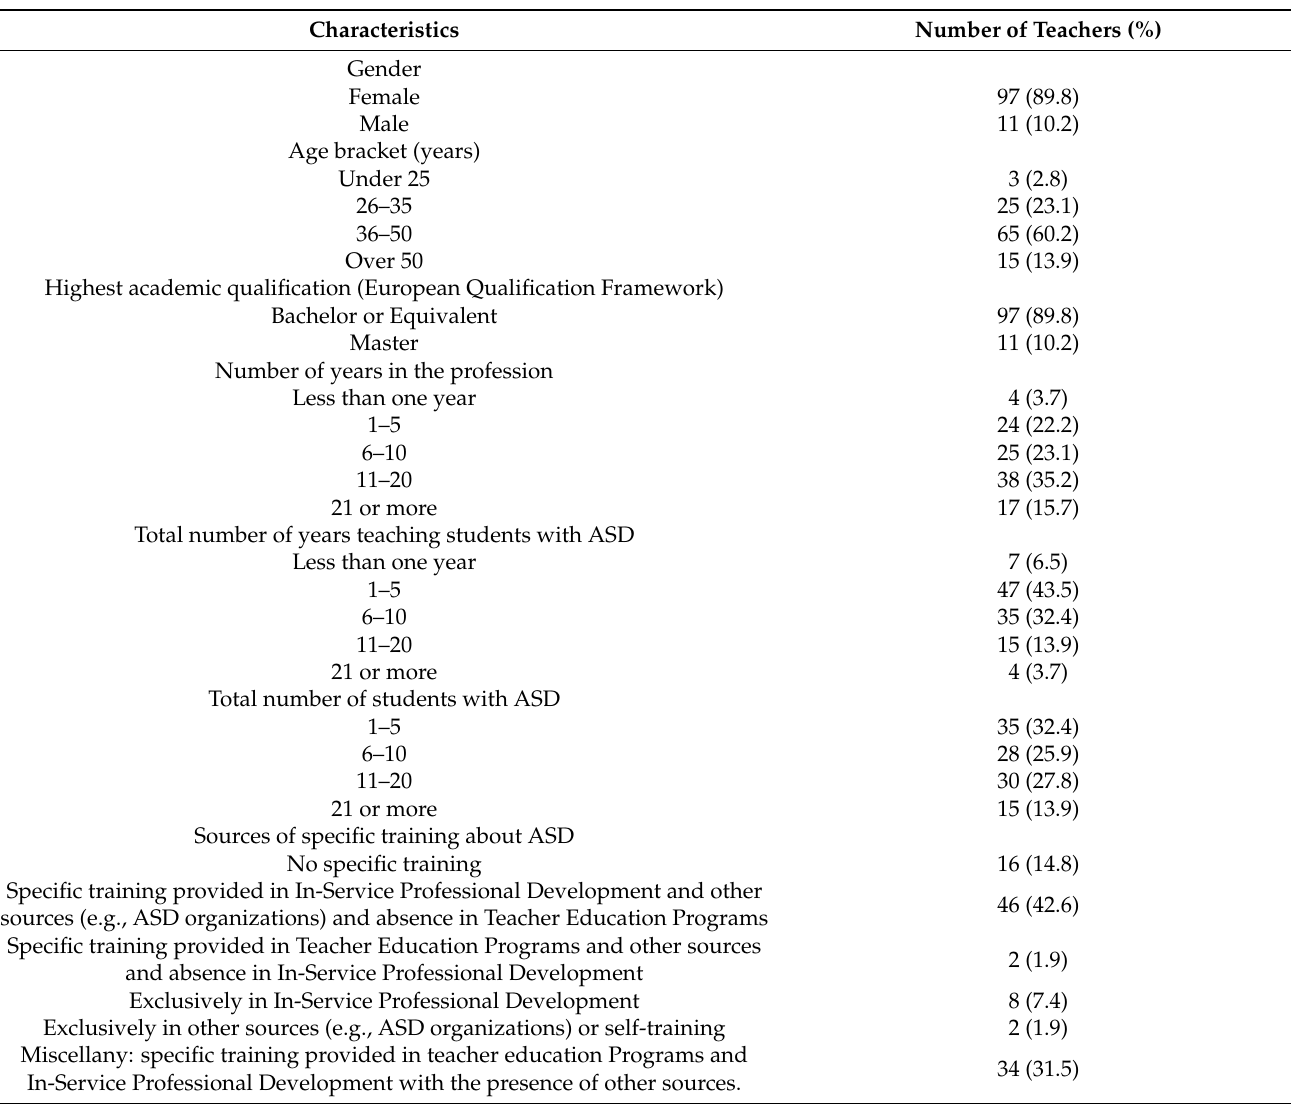
Table 1. Participant